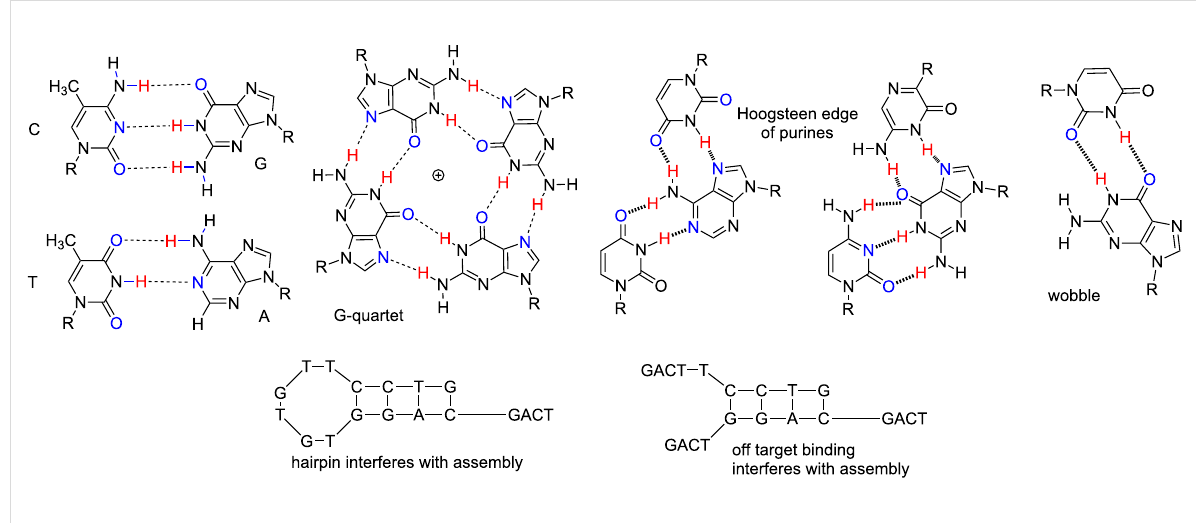
Figure 1: Some structures showing possible reasons why large DNA (L-DNA) constructs do not self-assemble from more than approximately a dozen synthetic single-stranded DNA oligonucleotides. Top from left to right: The presence of strong (C:G) and weak (T:A) nucleobase pairs complicates the design of self-assembling fragments. G-quartets can arise from G-rich sequences, with major groove interactions involving hydrogen bonding to the “Hoogsteen edge” of purines. Wobble pairing can compete with Watson–Crickery. Bottom. Even if Watson–Crickery were the only way for single stranded DNA sequences to interact, the low information density of four-nucleotide DNA allows easy off-target hybridization and unimolecular hairpin formation. Unimolecular processes (such as hairpin formation) compete with the desired intermolecular hybridization, especially at low concentrations of